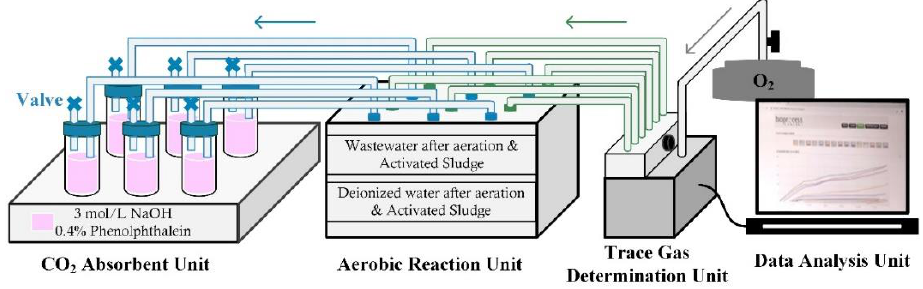
Figure 3. Evaluation experiment system of bio-treatment feature.